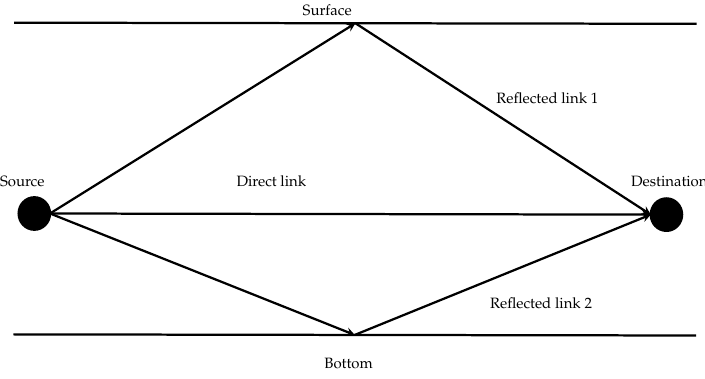
Figure 1. Example of multipath